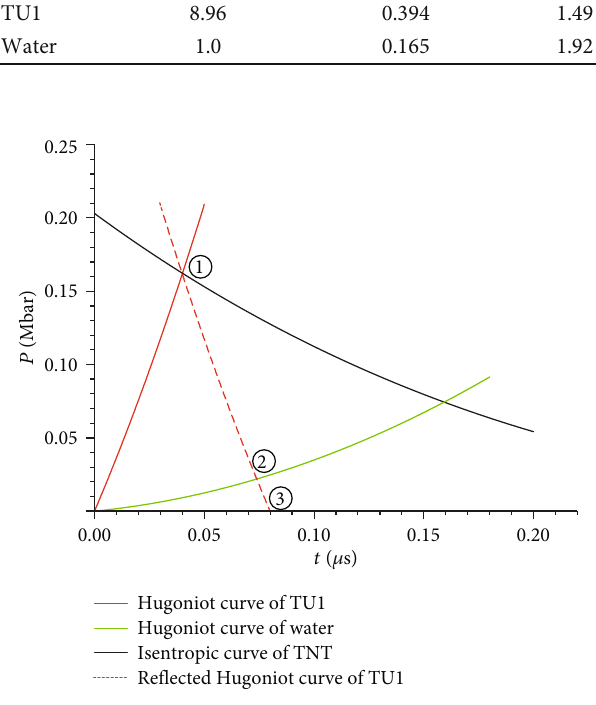
Figure 11: The analysis diagram of the stress wave propagation process.